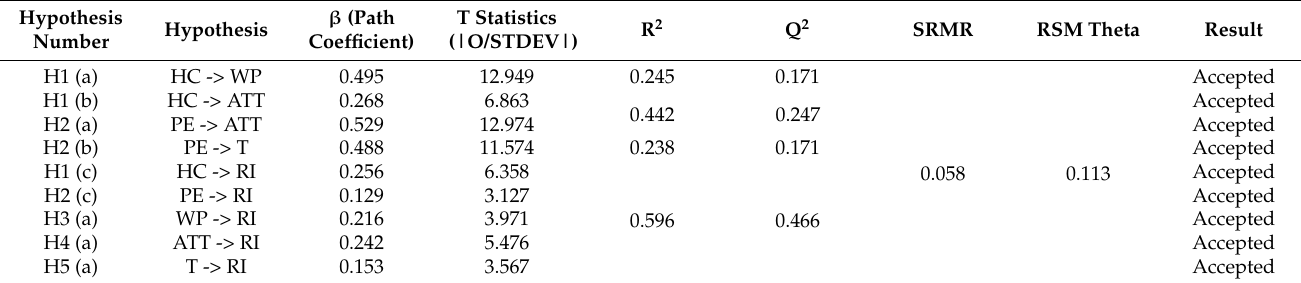
Table 6. Path coefficients and fitness indices for the structural model.